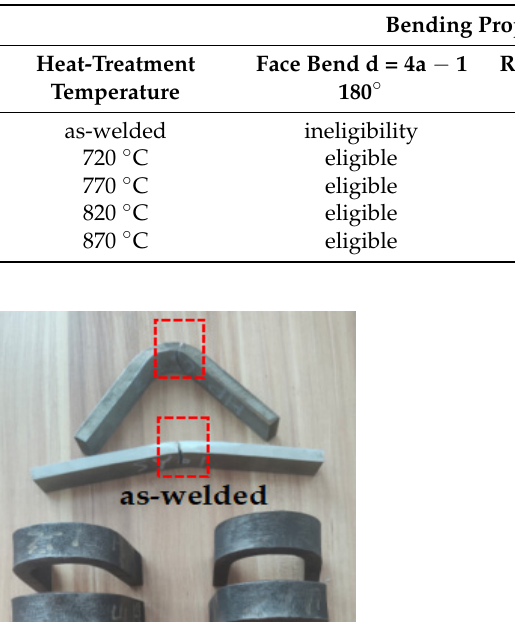
Table 5. Bending performance test report.